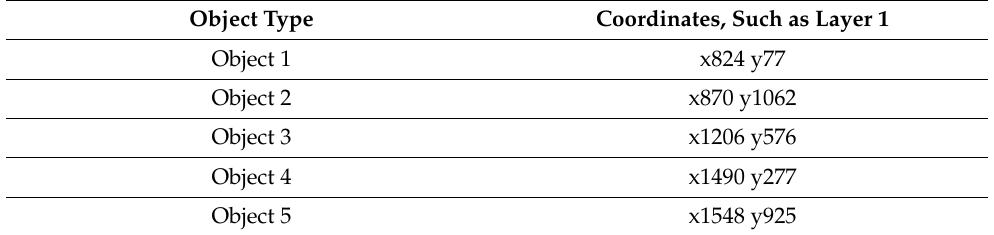
Table 1. Location of a given object’s center in relation to the coordinate axis on each of the layers.